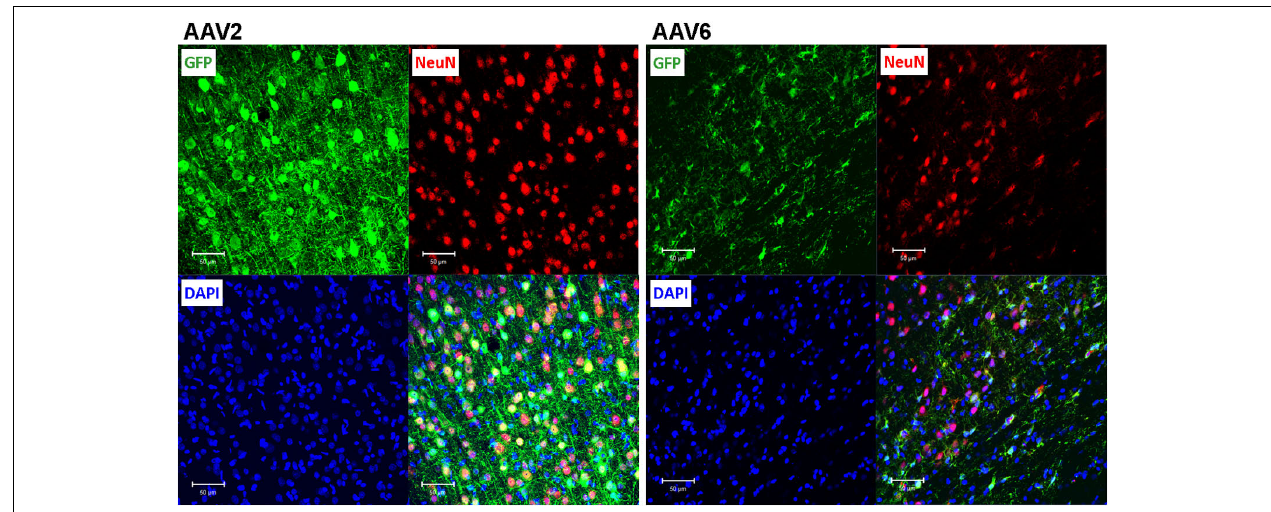
FIGURE 4 | Assessment of the ability of rAAV2 and rAAV6 to transduce neurons in the rat cortex. Slices were stained for GFP as a marker of viral transduction (green), the neuronal marker NeuN (red), and DAPI (blue). The bottom right images in each set show overlay of all three signals, with shades of yellow representing colocalization (at this magnification it is not obvious in some cells due to differences in signal intensities and cellular location). Z-stack images were taken using Zeiss LSM510 META confocal microscope at 250 × magnification and identical exposure settings. Scale bars = 50 µ m. Images are representative of at least 12 sections from four different rats for each